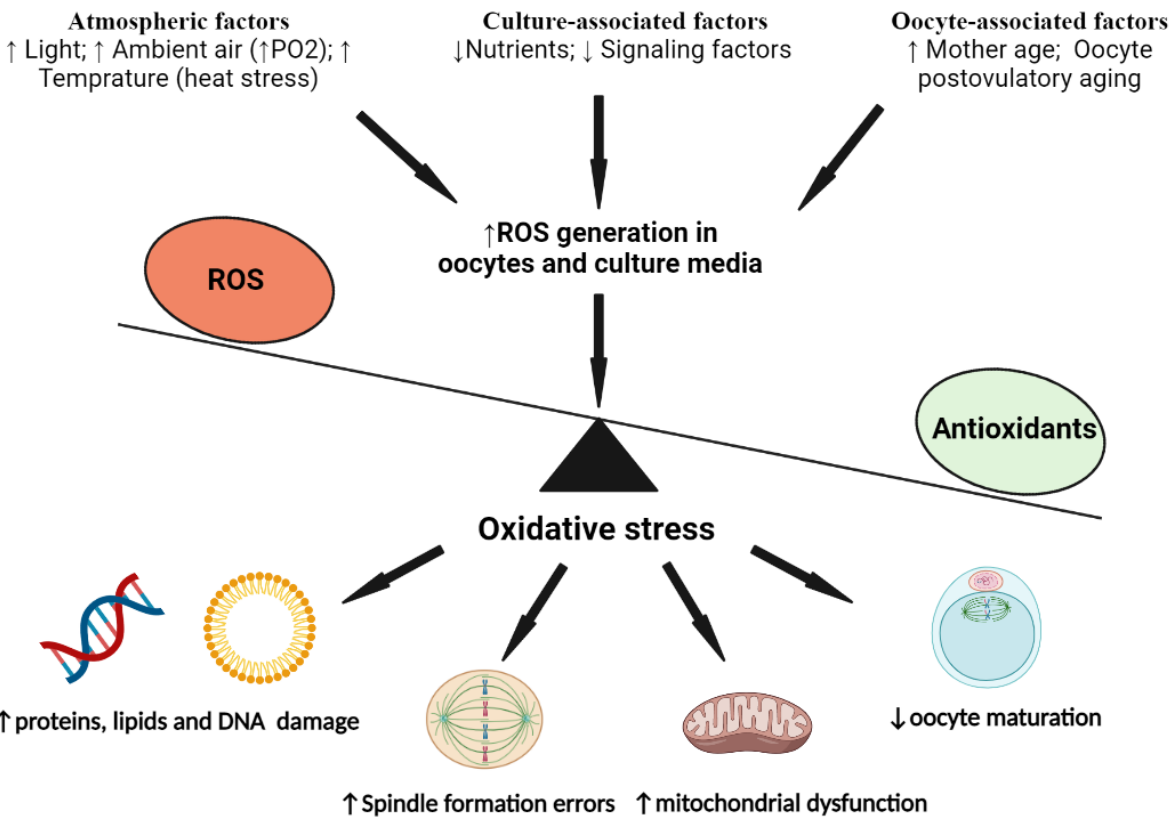
Figure 1. Schematic diagram summarizing the main factors causing oxidative stress of mammalian oocytes during their in vitro maturation. Consequences of oxidative stress on oocyte components are also shown. PO2, partial pressure of oxygen; ROS, reactive oxygen species. The diagram was created with BioRender.com [217].